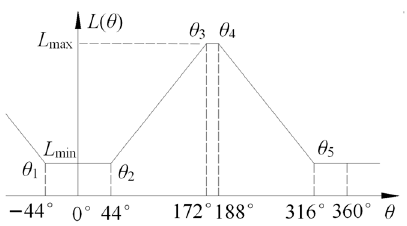
Figure 8. Linear inductance curve of three phase 12/8 pole SRM.